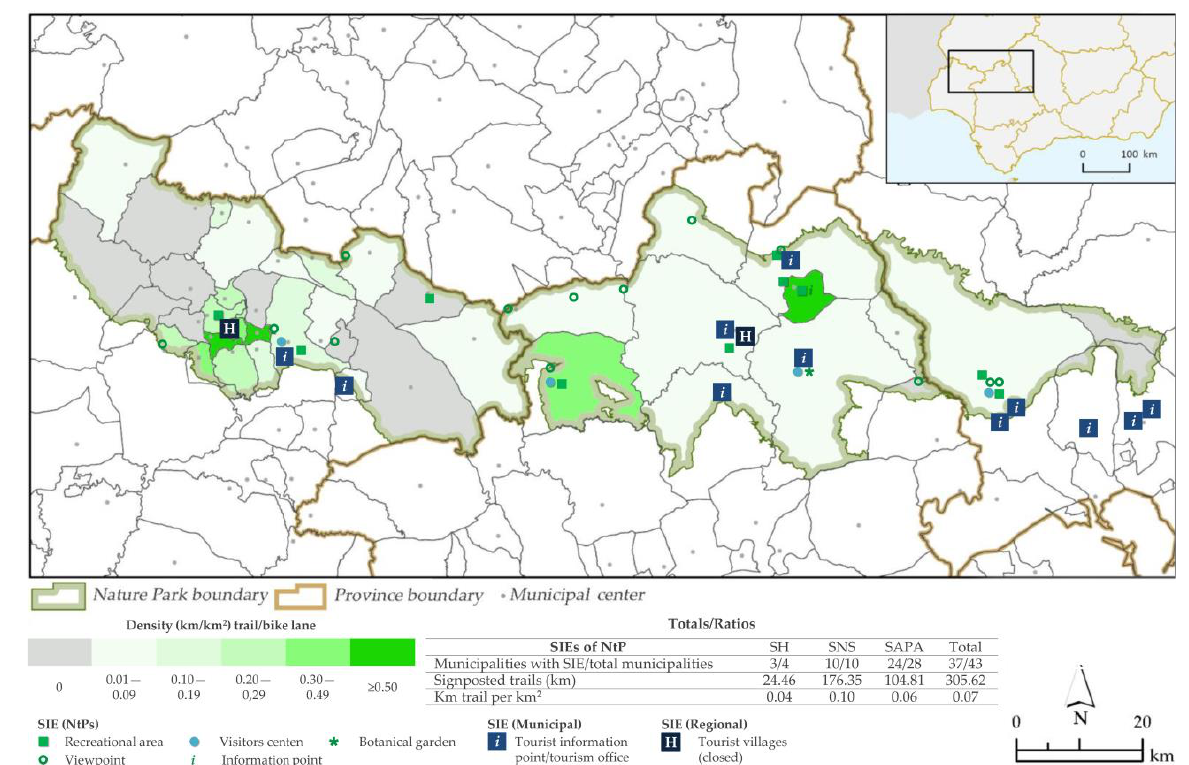
Figure 22. Public services, infrastructure, and equipment in the study area (2021). Sources: [79,86,88]; authors ’ elaboration.